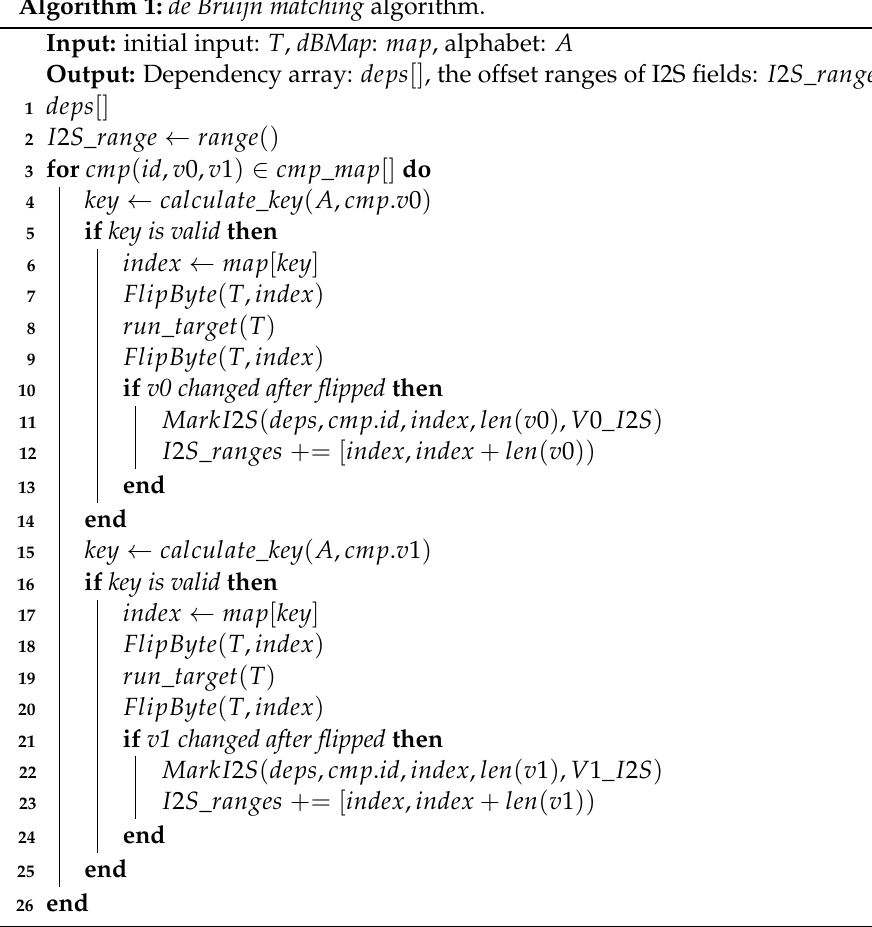
Algorithm 1: de Bruijn matching